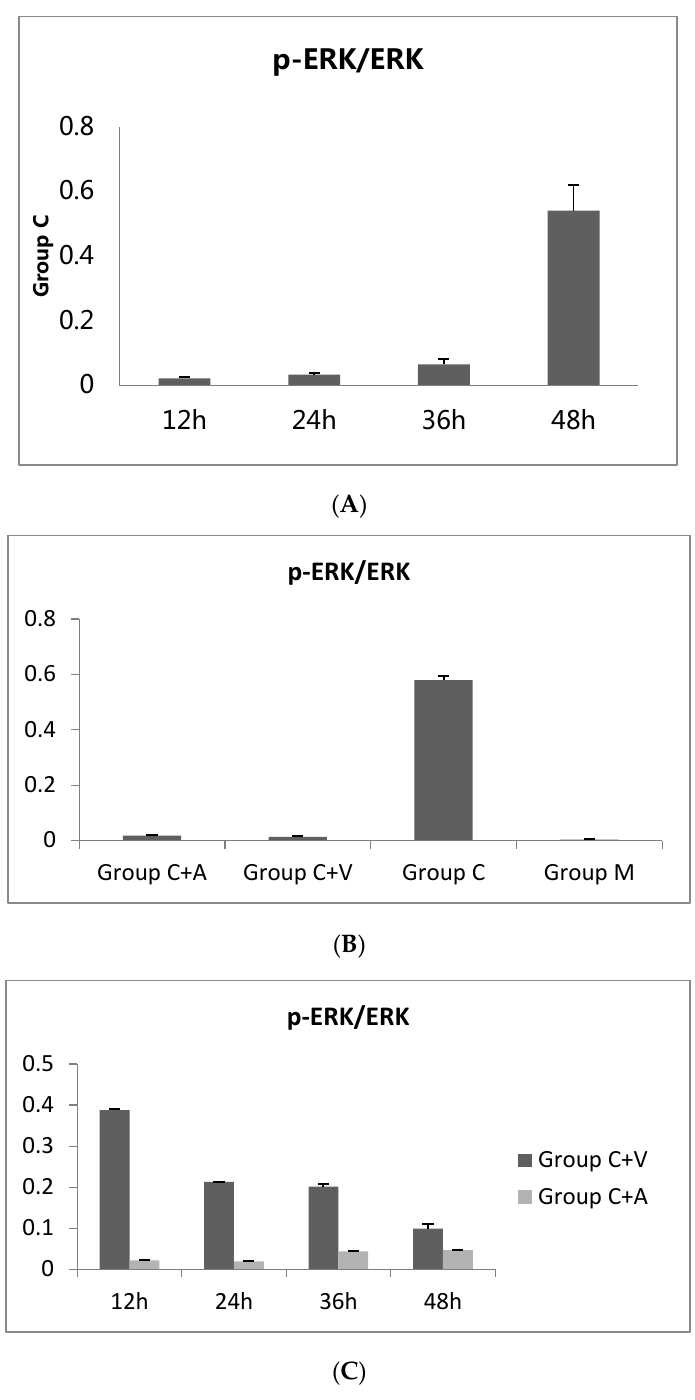
Figure 2. Grey value ratios of the ratio of p-ERK1/2 to ERK1/2 expression ( A ). Group C at different time points. * Statistically significant difference between the value at 48 h and other three other time points by one-way ANOVA, LSD (Least Significant Difference) ( p = 0.000); ( B ) four groups after 48 h of incubation. * Statistically significant difference compared with Group C by the Paris t -test ( p = 0.000); ( C ) Group C + V and Group C + A at different time points during the incubation. * Statistically significant difference compared with other three time points by one-way ANOVA, LSD ( p = 0.000). ** Statistically significant difference compared with the value of 12 h ( p = 0.000). # Statistically significant difference compared with the value of 12 h ( p = 0.028) and 24 h ( p = 0.017). ## Statistically significant difference compared with the value of 12 h ( p = 0.016) and 24 h ( p = 0.009). Group C + A, the azithromycin-treated group. Group C + V, the Vp1-treated group. Group C, the Chlamydia trachomatis group. Group M, the blank group (only McCoy cells).